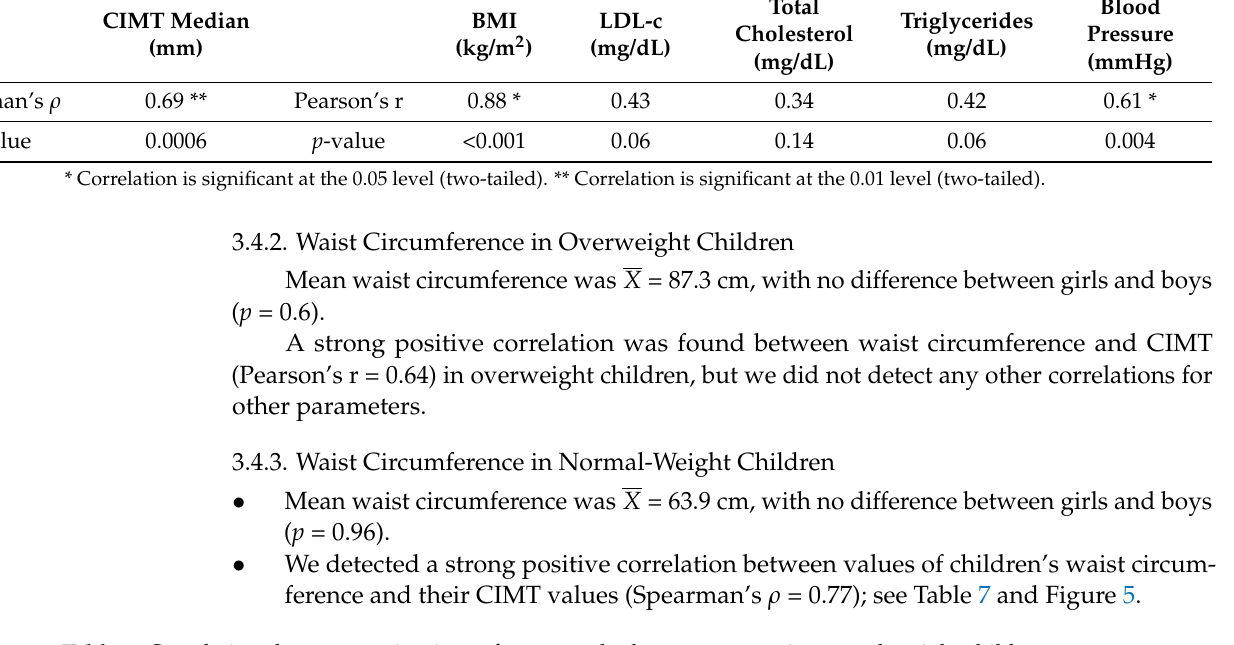
Table 7. Correlations between waist circumference and other parameters in normal-weight children. CIMT